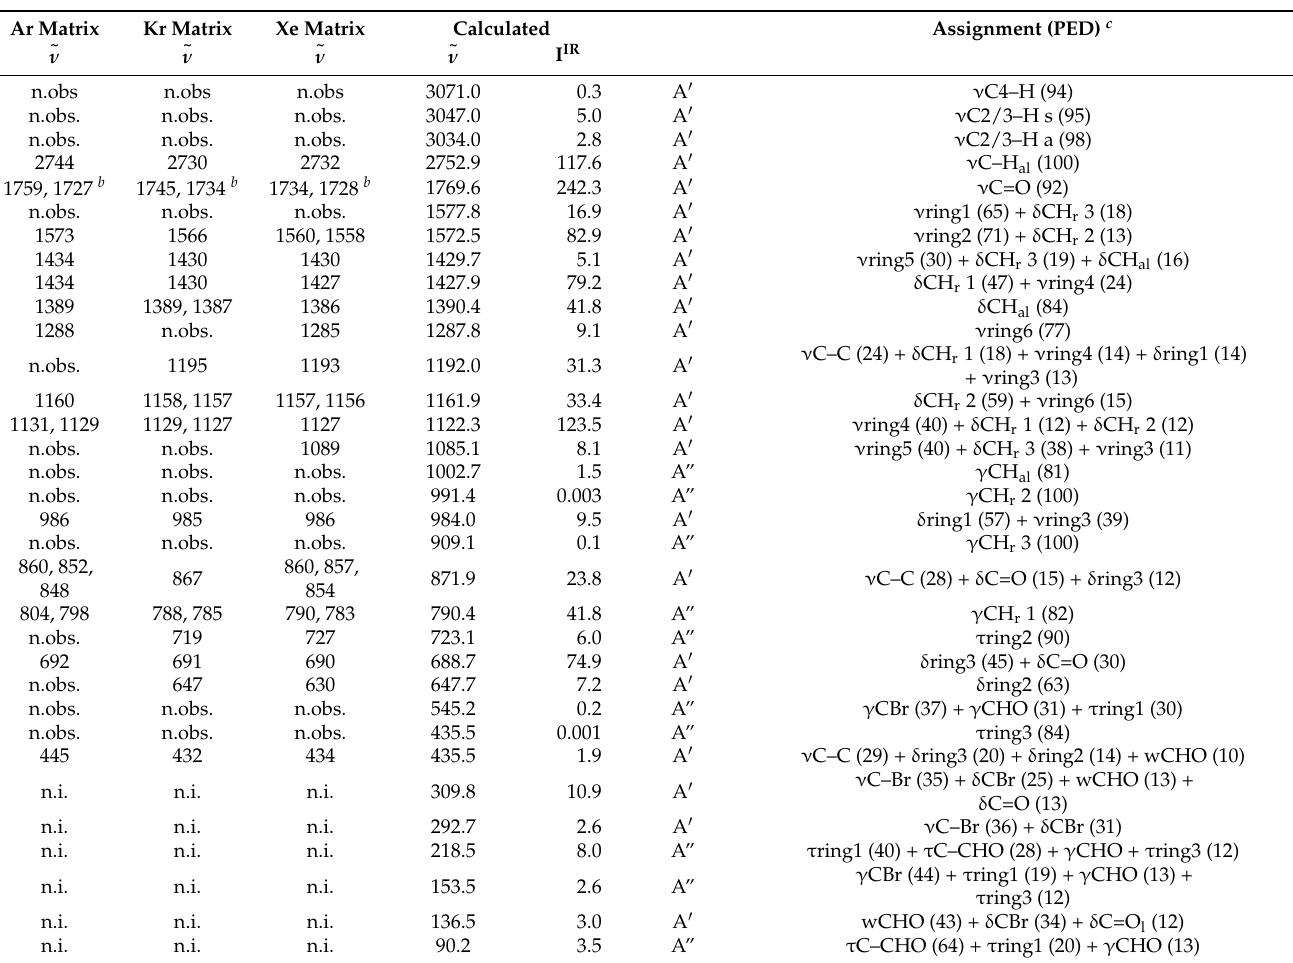
Table 3. Assignment of the IR spectrum of the photoproduced cis conformer of BPCA in Ar, Kr and Xe matrices and calculated PEDs a